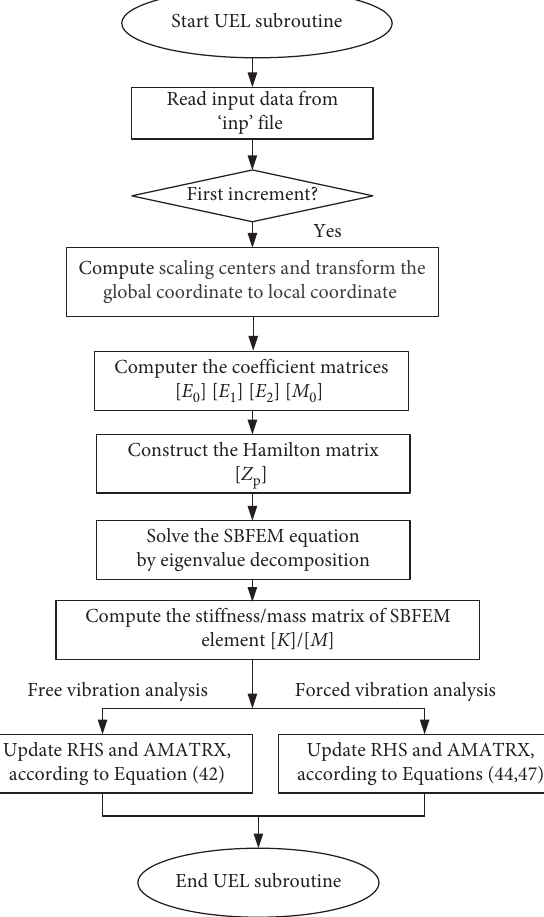
Figure 2: Framework of implementing the UEL in free vibration and forced vibration